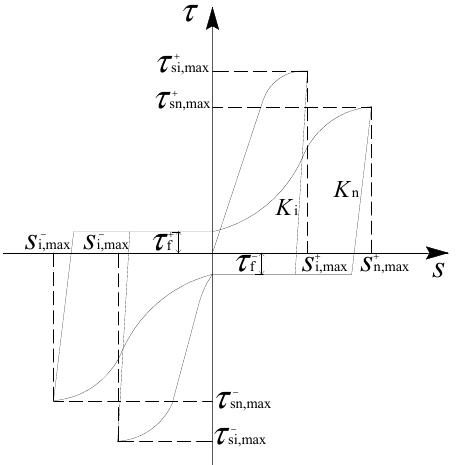
Figure 10. A schematic diagram of the bond–slip relationship under cyclic loading. (1) Degradation of positive peak bond stress.